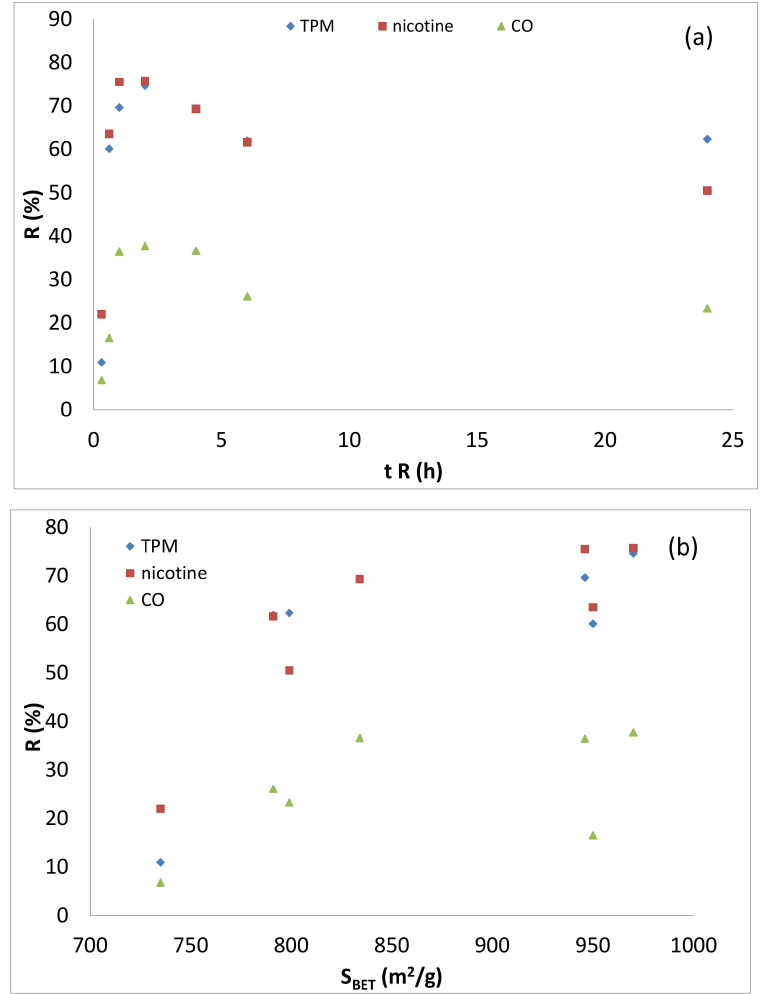
Figure 12. Influence of ( a ) reaction time and ( b ) BET area on the reductions of TPM, nicotine and